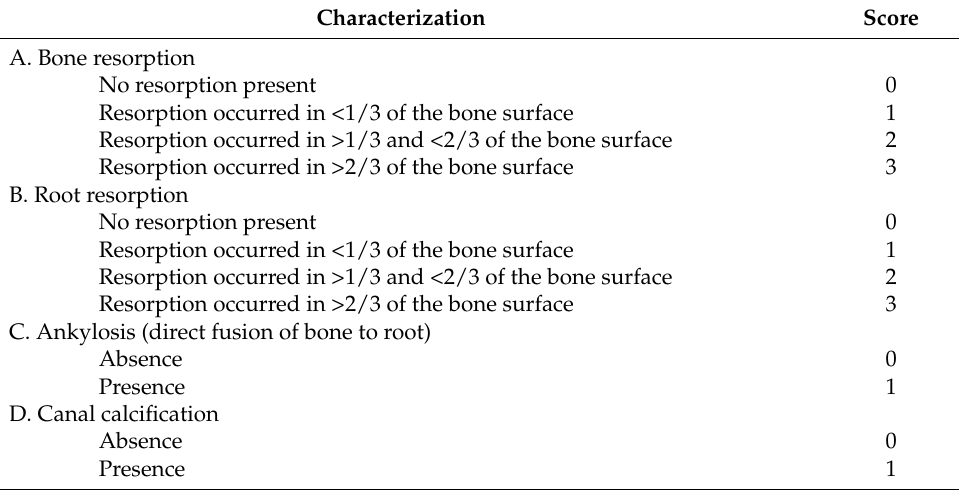
Table 2. Scores for quantitative analysis in micro-computed tomography